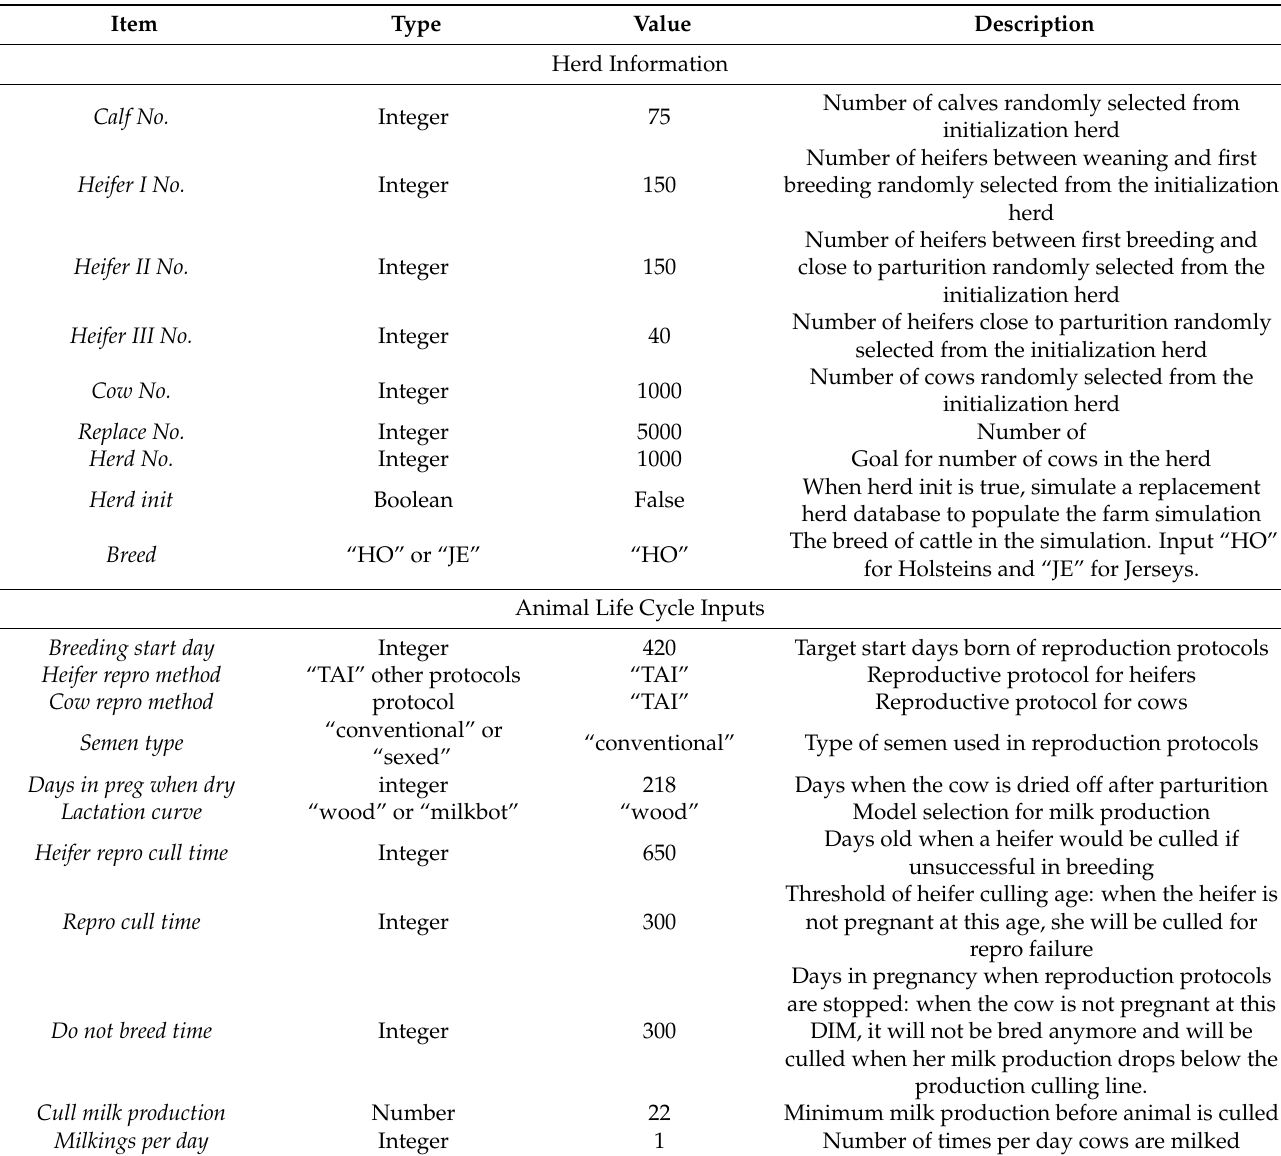
Table A1. User inputs in the Ruminant Farm Systems Model related to herd